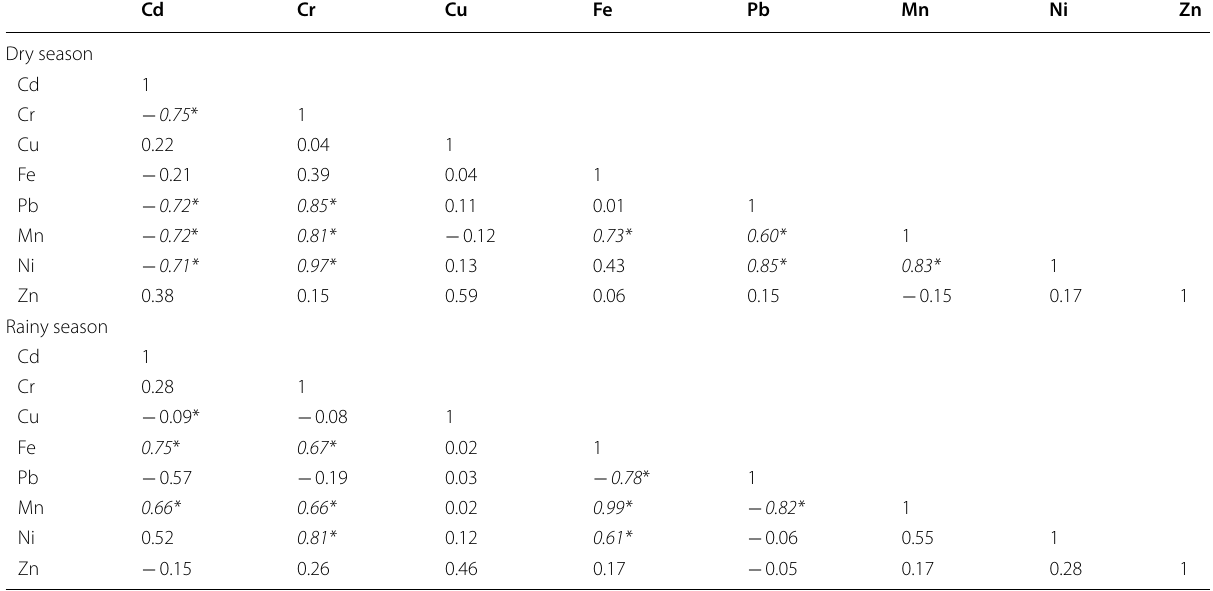
*Correlation is significant at p < 0.05 level